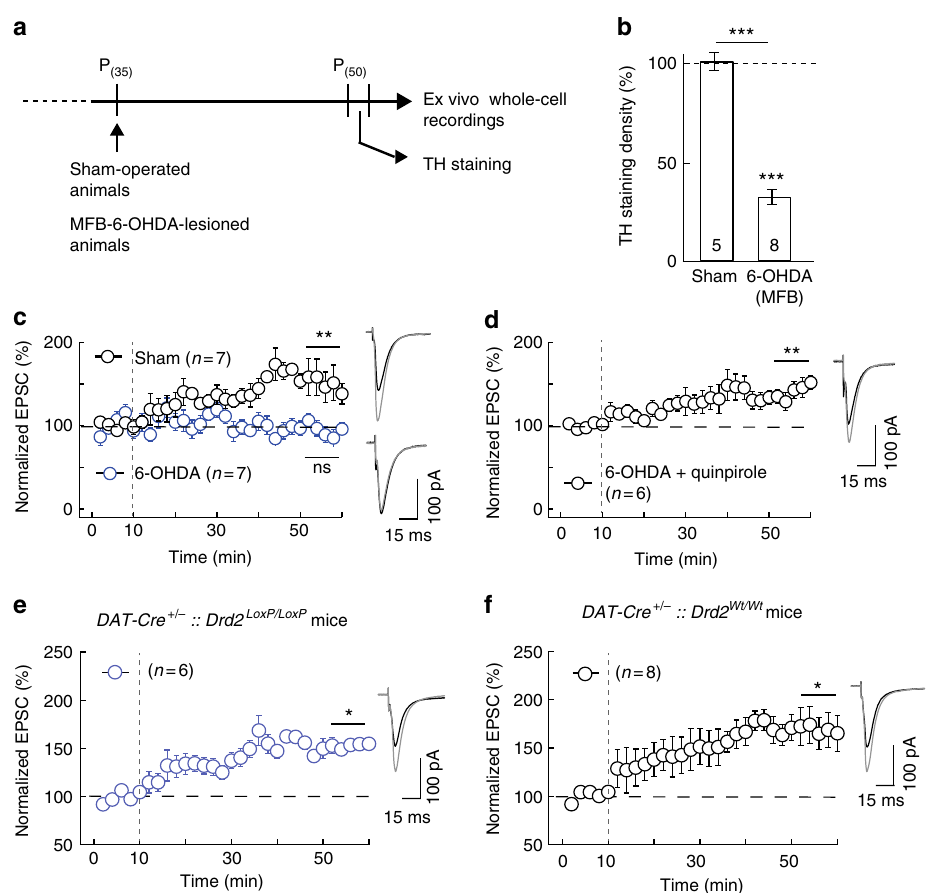
Fig. 6 eCB-tLTP does not depend on D 2 R expressed by dopaminergic neurons. a – d Experiments of plasticity expression in 6-ODHA-ablated dopaminergic cells in the MFB. a Scheme of the protocol showing the time course of the in vivo 6-OHDA lesions and ex vivo electrophysiological recordings. b Unilateral 6-OHDA injection in MFB led to degeneration of dopaminergic nigral neurons, illustrated by a loss of their striatal afferences as illustrating by the summary bar graph of TH immunostaining quanti fi cation. Sham-operated rats display equivalent TH staining in both striata. c 10 post-pre pairings induced tLTP in sham-operated ( n = 7, 7/7 cells showed tLTP) rats whereas tLTP was impaired in 6-OHDA-lesioned rats ( n = 7, 1/7 cells showed tLTP), and d rescued with a D 2 R agonist, quinpirole (10 µ M, n = 6, 5/6 cells showed tLTP). e , f STDP expression in selective cKO for D2R expressed by dopaminergic neurons. e In mice in which D 2 R was speci fi cally knocked-out in dopaminergic neurons ( DAT-Cre + / − ::Drd2 LoxP/LoxP mice) tLTP was induced with 15 post-pre pairings ( n = 6, 6/6 cells showed tLTP). f tLTP was observed in mice serving as the Cre driver control ( DAT-Cre + / − ::Drd2 Wt/Wt mice, n = 8; 6/8 cells showed tLTP). Representative traces are the average of 15 EPSCs during baseline (black traces) and 45 min after STDP protocol (grey traces). Vertical grey dashed line indicates the STDP protocol. Error bars represent sem. * p < 0.05; ** p < 0.01; *** p < 0.001; ns: not signi fi cant by Wilcoxon Signed rank test ( b ) or